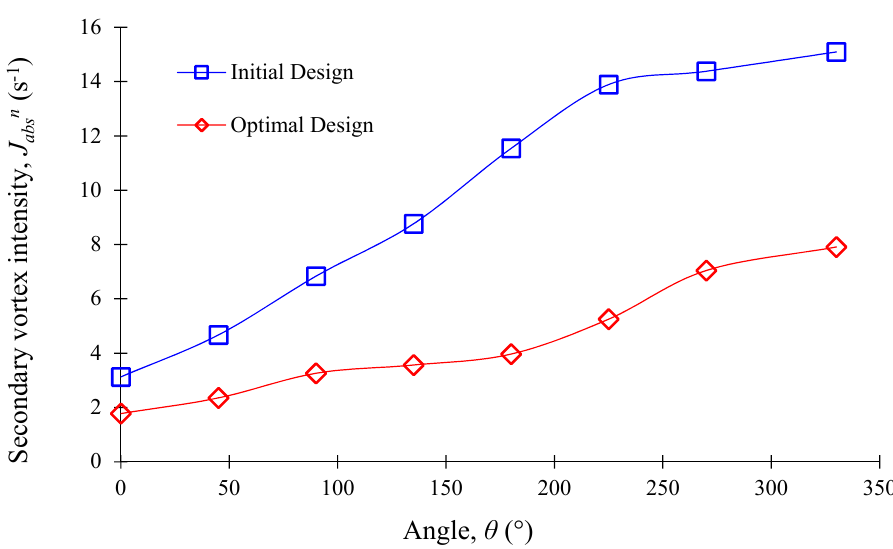
Figure 19. Comparison of secondary vortex intensity between initial and optimal casing designs.